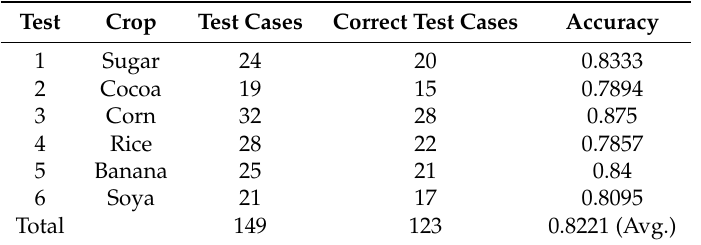
Table 5. Test results—diagnosis of crop insect